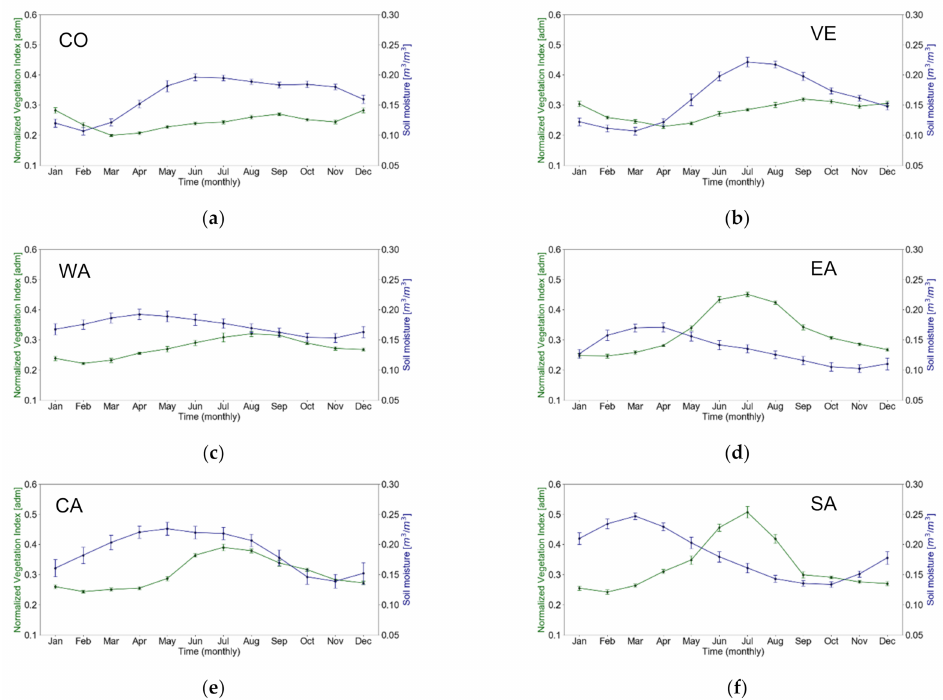
Figure 2. Long-term mean (2010–2018) annual cycles of NDVI and soil moisture in the six studied regions. Error bars denote the standard error of the mean. ( a ) CO: Colombia, ( b ) VE: Venezuela, ( c ) WA: West Amazonia, ( d ) EA: East Amazonia, ( e ) CA: Center Amazonia, and ( f ) SA: South